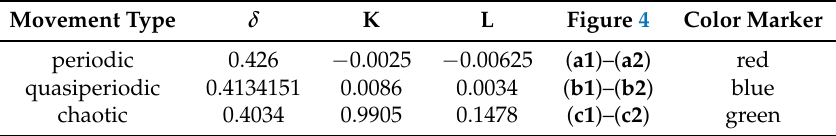
Figure 4. IHCOM Equation (11) with ∆ = 1: time histories (( a1 ),( b1 ),( c1 )), PSD (( a2 ),( b2 ),( c2 )), and translation variables plot in p − q plane (( a3 ),( b3 ),( c3 )) for periodic ( a ), quasiperiodic ( b ), chaotic ( c ) movement for parameters δ given in Table 2; ( d ) aggregated density plots for all three cases with color inherited. Table 2. Summarized parameters and outputs of Figure